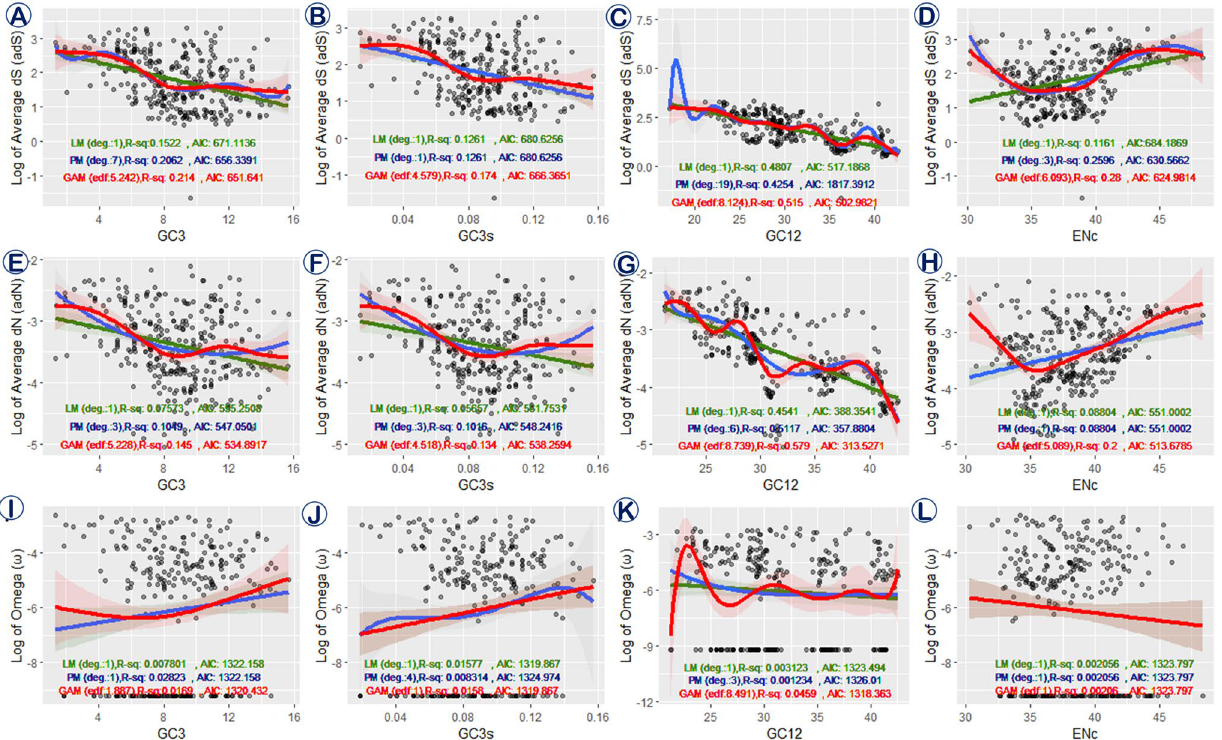
Figure 10. Univariate regression model fitting between logarithmic response variables, divergence rate (dS, dN and ω) and predictor variables, codon usage indices (GC3, GC3s, GC12, ENc) of training datasets; ( A – D ): log of average synonymous divergence (adS) rate vs codon usage indices; ( E – H ): log of average nonsynonymous divergence rate (adN) vs codon usage indices; ( I – L ): log of omega ratio (ω) vs codon usage indices; Green: Linear Model (LM), Blue: Polynomial Model (PM), Red: Generalized Additive Model (GAM), light colour represent the 95% confidence interval; R-sq (R 2 ): Coefficient of determination; AIC: Akaike information criterion; deg: degree, edf: effective degrees of